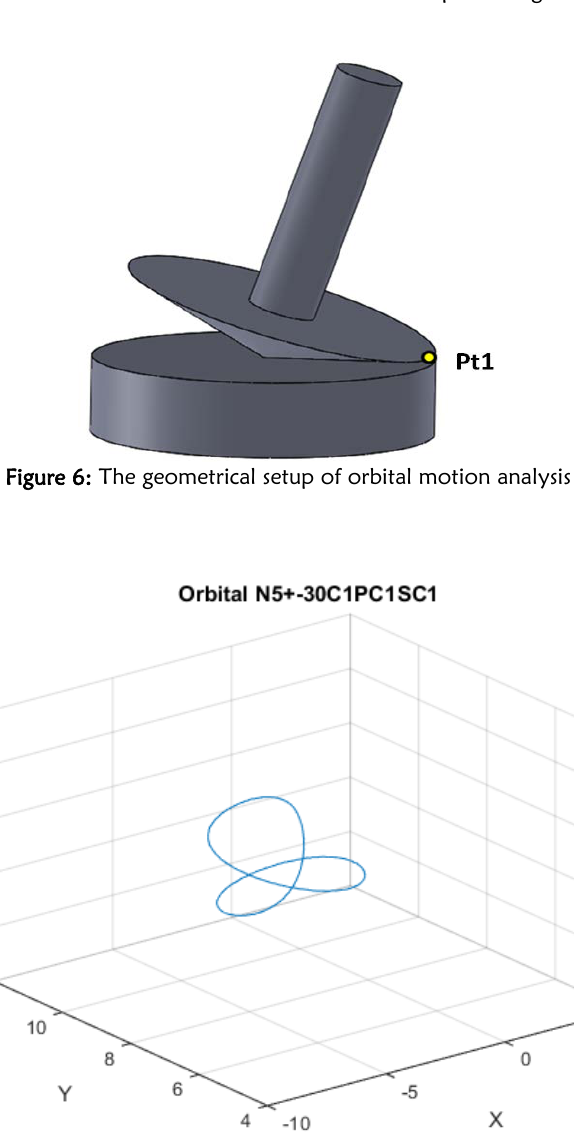
Figure 7: Orbital plot of point Pt1 with N (Nutation angle) = 5O±30O with P (Precession) and S (Spin) are rotated